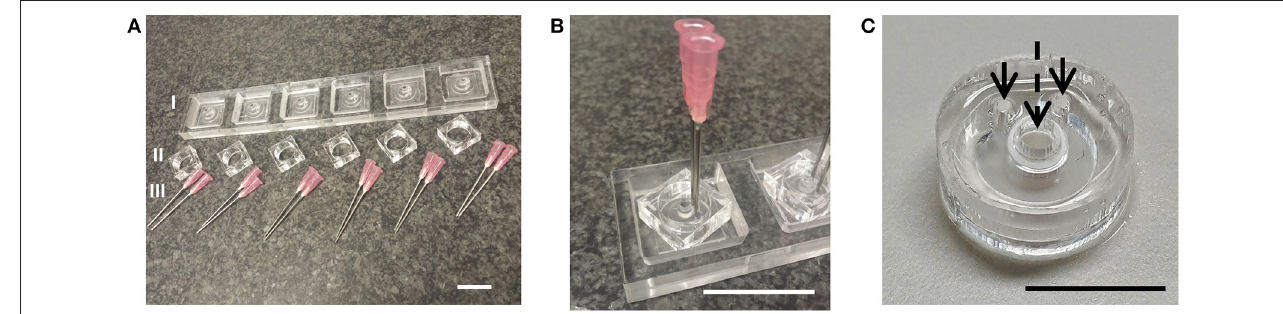
FIGURE 2 | Microbioreactor mold and fabrication result. (A) Parts of the mold for the fabrication of the PDMS part of the microbioreactor. The primary mold I was made using micromilling of PMMA, which allowed for the production of multiple copies. To ensure the PDMS could be removed after soft lithography from the mold, the side walls II were made from separate pieces of PMMA. For the inlets of the microfluidics channels, flat-tipped needles III were inserted into the mold. (B) The assembled mold. Scale bars in (A,B) denote 3cm. (C) Resulting PDMS microbioreactor with PES tube, with arrows denoting inlets to the microfluidic channel and the dashed arrow denoting the culture chamber inside the PES tube. Scale bar denotes 1cm.